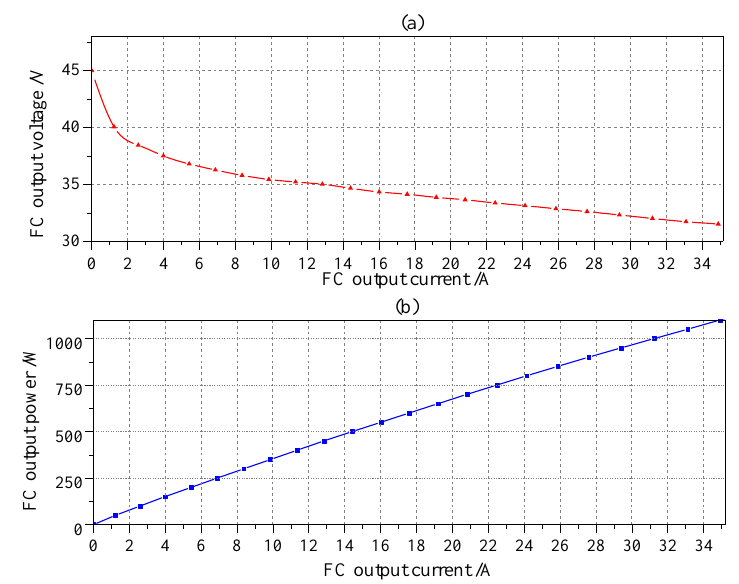
Figure 4. PEMFC voltage and power polarization curve. ( a ) The relationship between voltage and current; ( b ) The relationship between current and power.